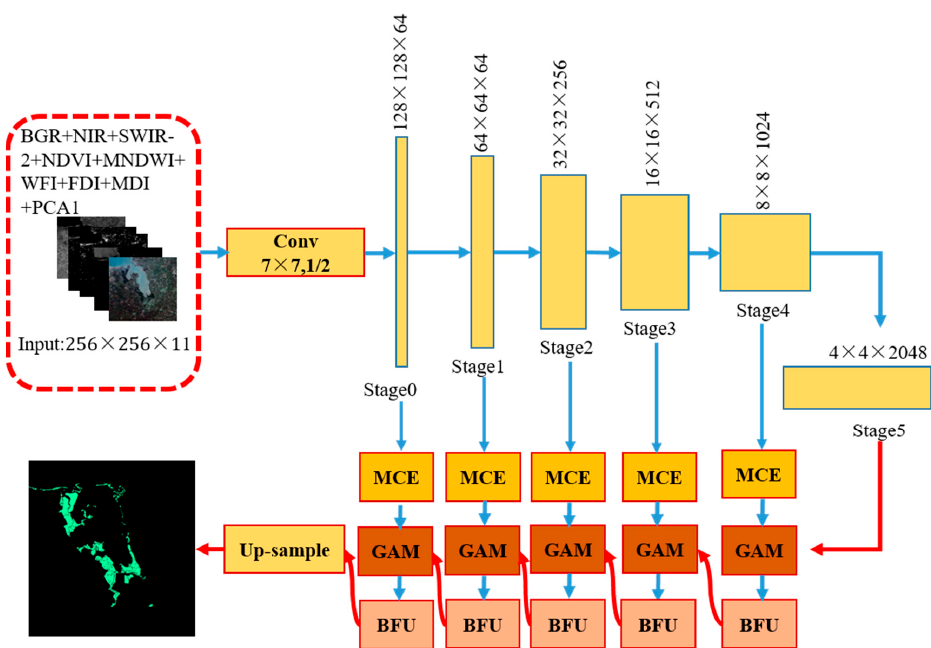
Figure 3. Architecture of the ME-Net. Arrows represent different operations, among which blue arrows represent convolution and pooling and red represents up-sampling; MCE: multiscale context embedding (MCE); GAM: global attention module; BFU: boundary fitting unit.